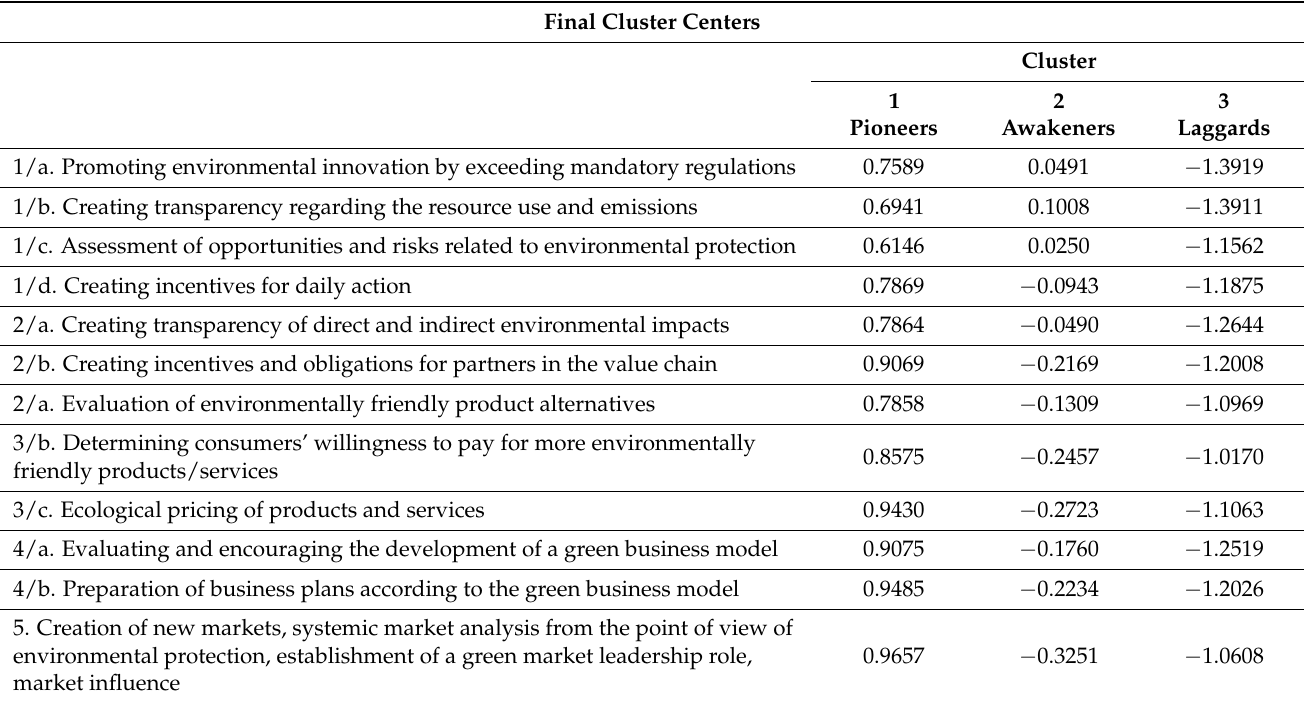
Table 6. The cluster centers in the examined sample for the present. Source: edited by authors. Final Cluster